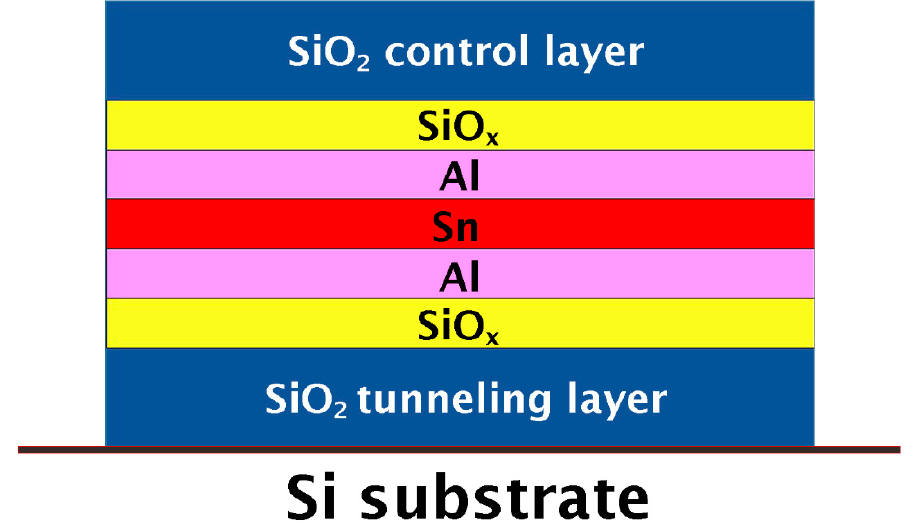
Figure 1. Cross-sectional schematic representation of the stacked structure employed in preparation the Sn@Al 2 O 3 core-shell of the Sn@Al 2 O 3 core-shell nanoparticles.